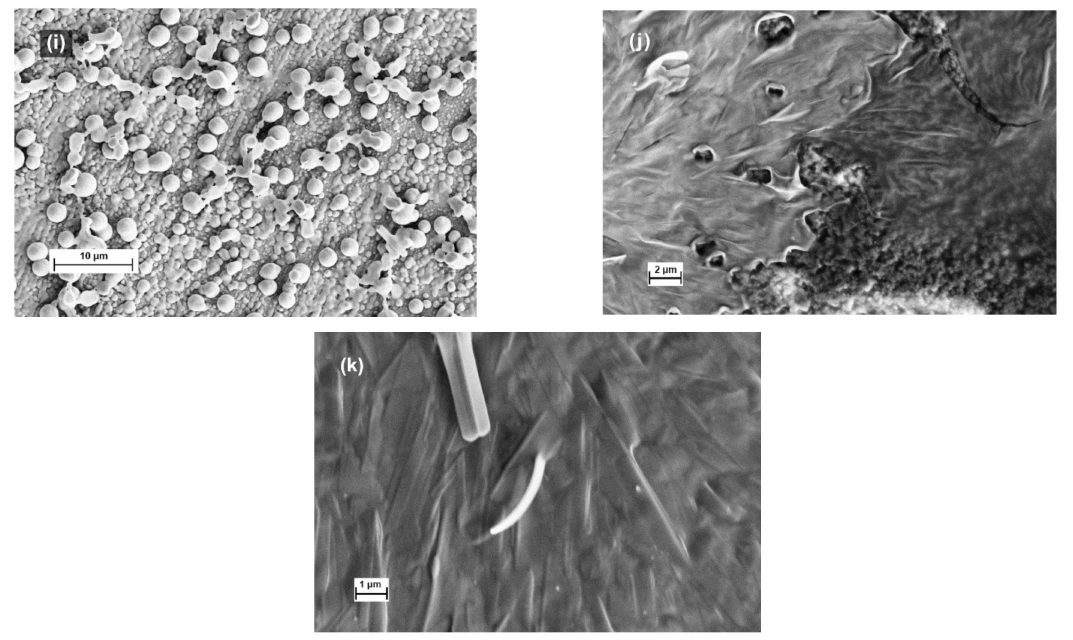
Figure 10. SEM images of copolymer IV-V films casted from different solvents. Annealed films of copolymer IV( a ) and copolymer V ( b ) casted from toluene. Cross-linked films of copolymer IV( c , d ) casted from chloroform; and copolymer V ( e , f ) casted from butyl acetate or ( g , h ) hexafluorobenzene. Cross-linked films of copolymer V( i ) casted from emulsion in carbon tetrachloride or chloroform ( j , k ).